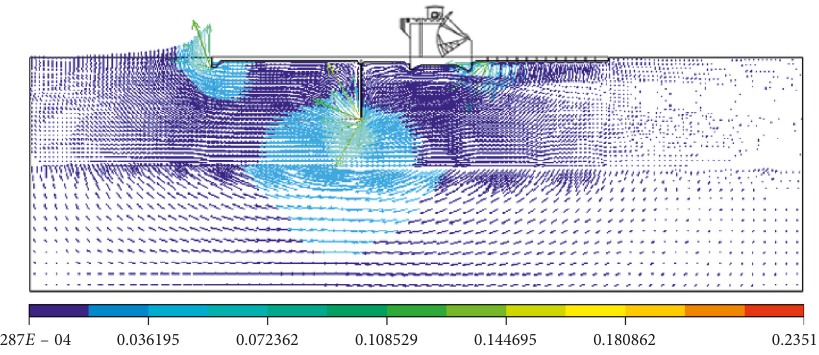
Figure 26: Seepage gradients in 2# sluice foundation in flood season.